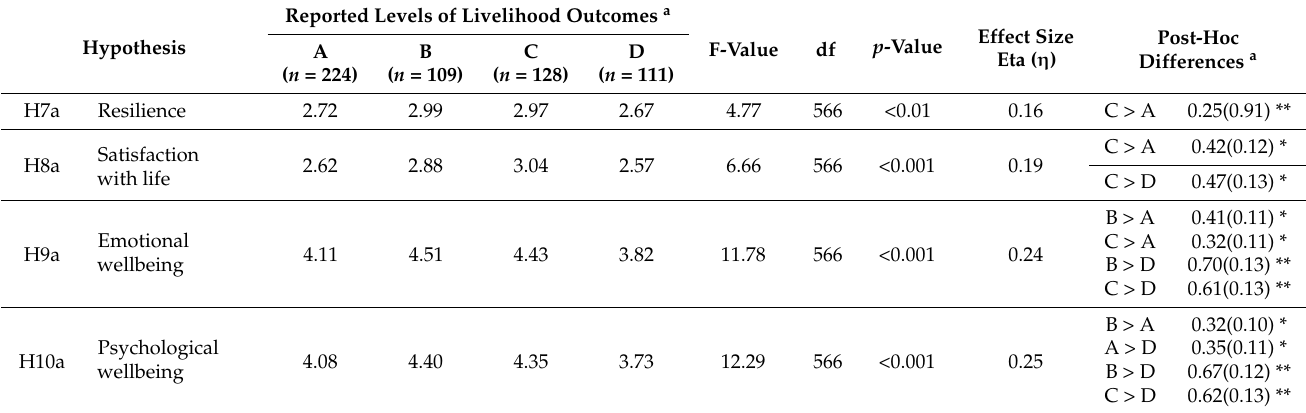
Table 6. Differences in livelihood outcomes compared by incentive